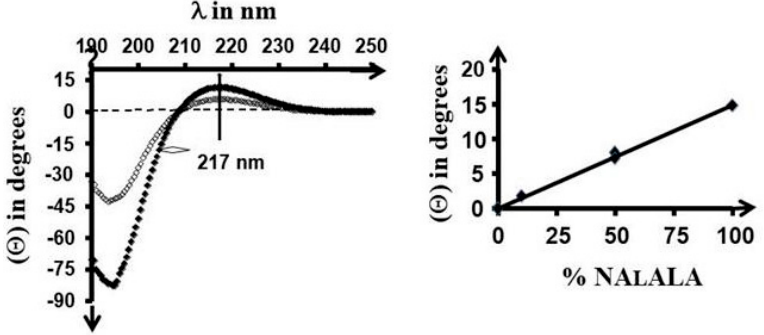
Figure 7. Circular Dichoïsm (CD) spectra of PNA L ALA ■ : [C]= 0.25% W/V; □ : [C]= 0.125% w/v in water at 20 °C ( left ) and changes of ellipticity ( θ ) at 217 nm ( right ) as a function of the composition of copolymers in NA L ALA-based units deduced from the 1 H-NMR spectra shown in Figure 3. Differences in ellipticity of replicates are inside the size of data points, as shown by duplicates for 50% NA L ALA. This finding shows that NAGA units did not perturb the chiral properties due to NA L ALA ones.